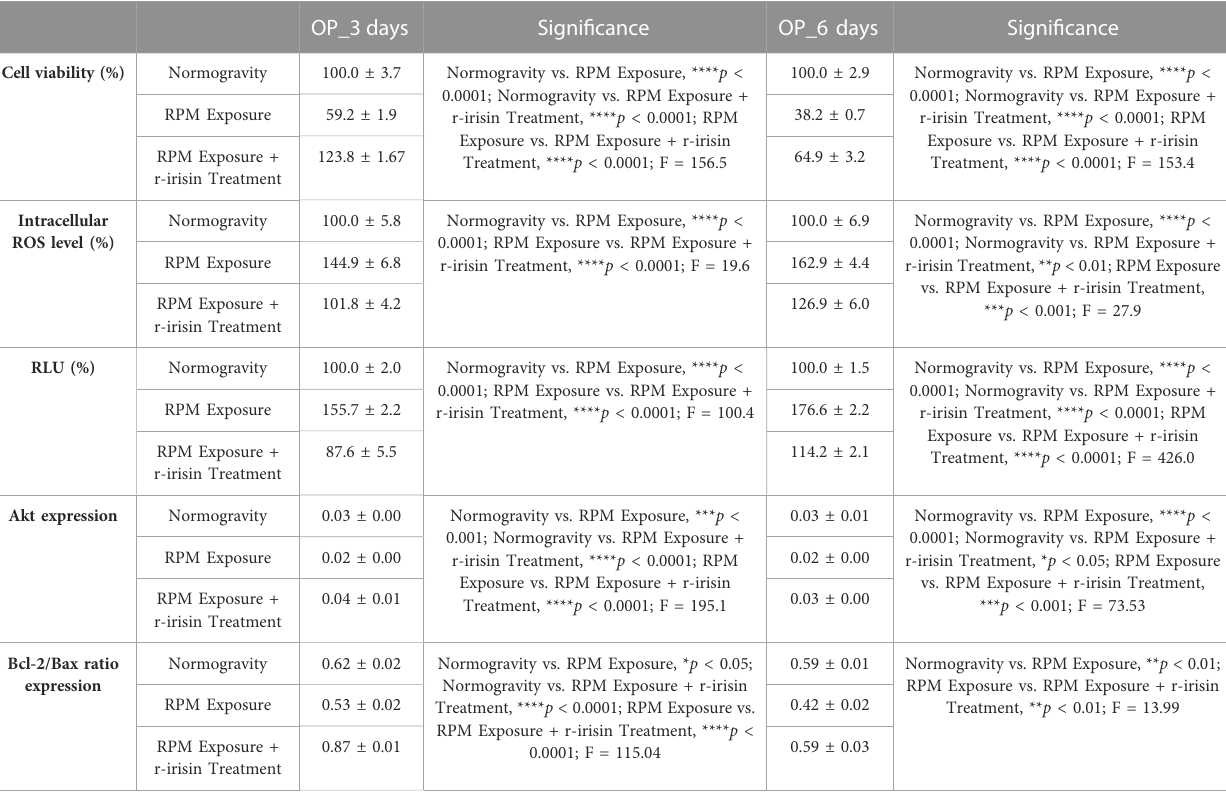
TABLE 3 Mean values ± standard error and relative signi fi cance for the cell survival assessment in OP patients after 3 and 6 days of RPM